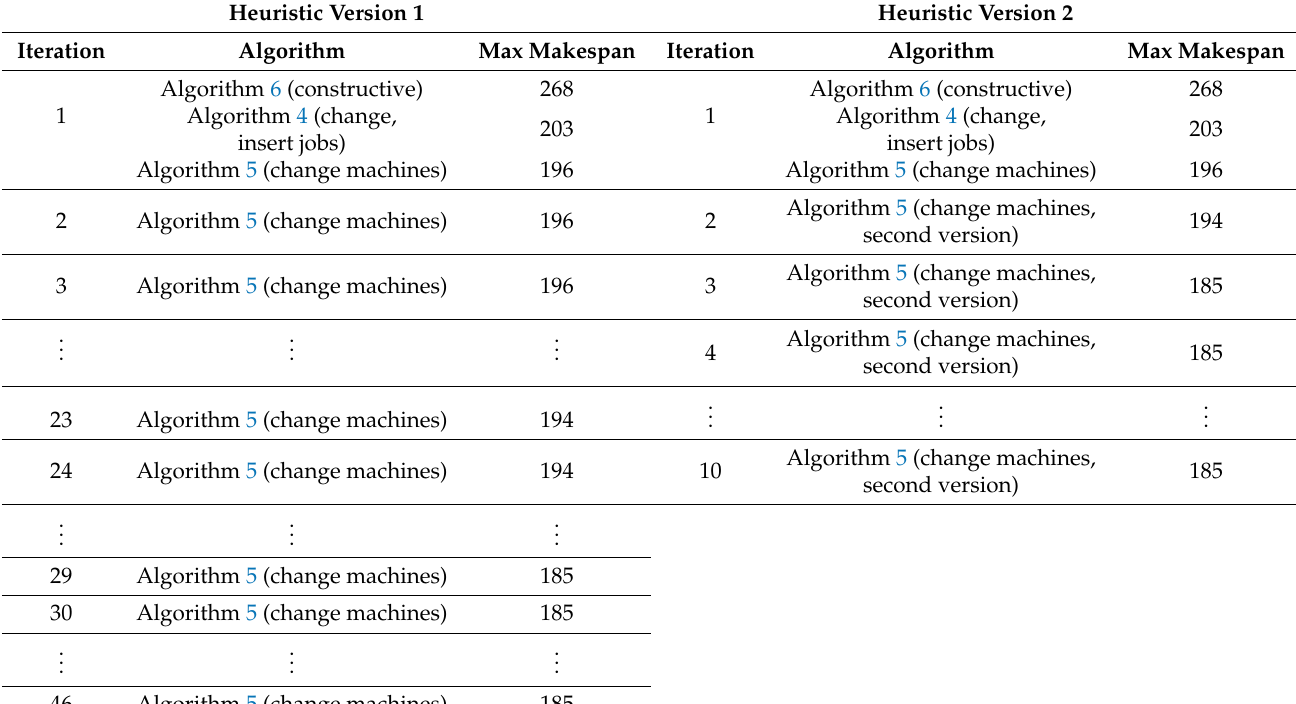
Table A1. Summary of results, two alternatives of the heuristic.